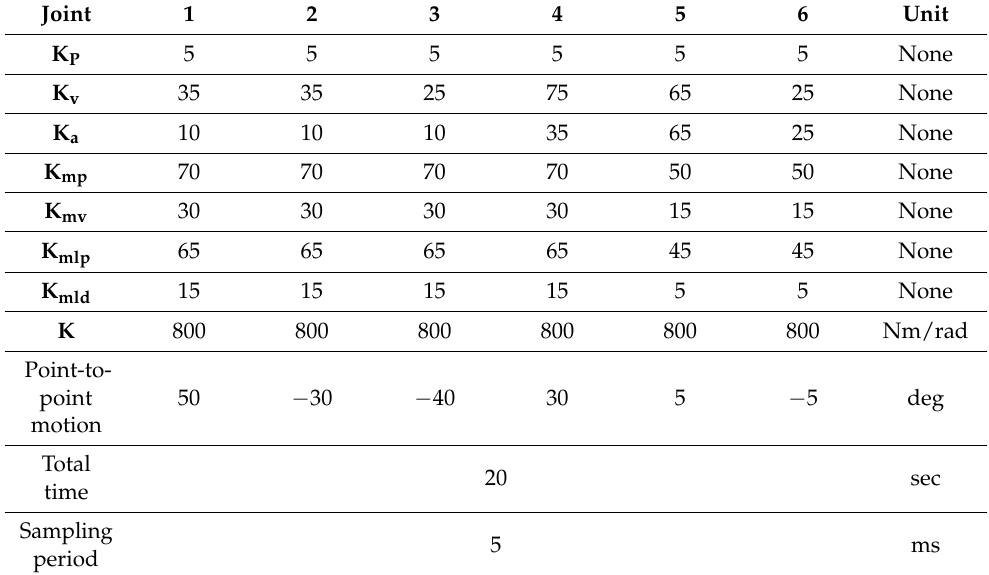
Table 2. Simulated control parameters.